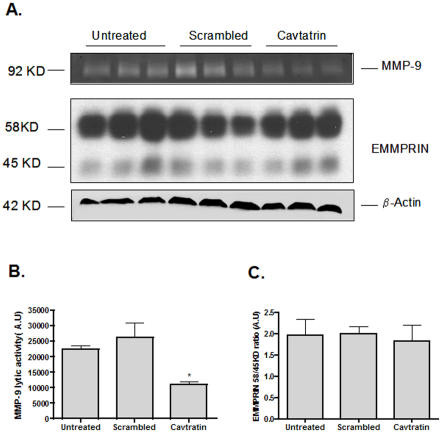
Cavtratin, MMP-9 and EMMPRIN in Raw-264.7.A- Top, representative zymogram of culture supernatant from Raw-264.7 macrophages. 1×106 cells were incubated in a serum-free medium with Cavtratin or scrambled peptides (10 µM) for a period of 24 hours. Thereafter, culture media was collected and centrifuged for 5 minutes at 2000 rpm at 4C and subjected to gelatin zymography. Little or undetectable signal was observed for MMP-2. Middle, EMMPRIN expression levels in total cell lysates obtained from Raw-264.7 cells and representative western blot for β-actin (bottom panel). B- Quantification of MMP-9 lytic activity in the culture supernatant. * P = 0.02. C- Quantification of EMMPRIN expression levels. Data presented were normalized by β−actin expression.